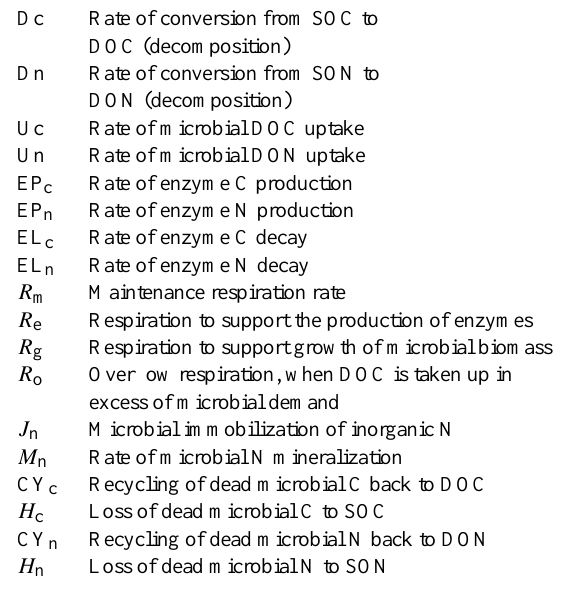
Table A2. Model Pools. Table A3. Model